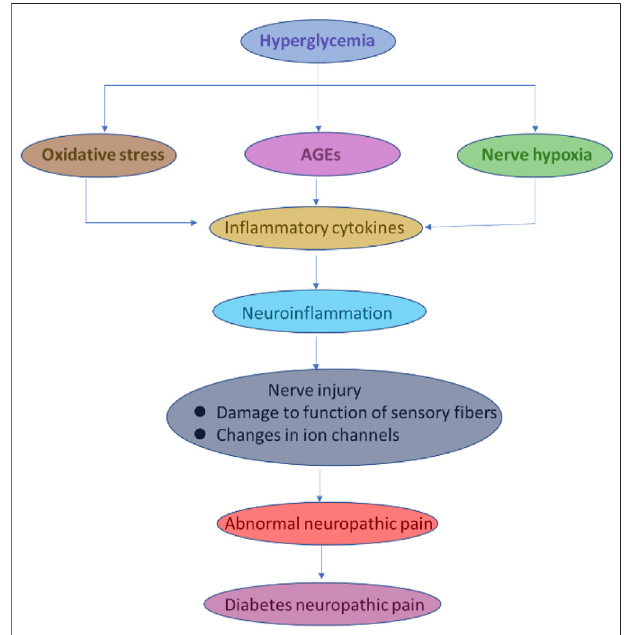
FIGURE 6 | Graphical explanation of pain pathogenesis in